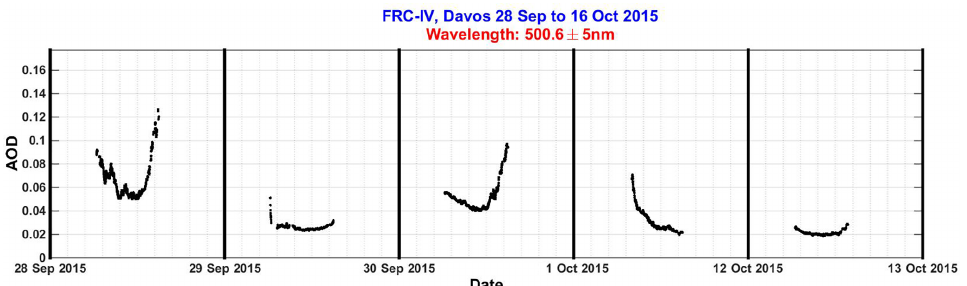
Figure 1. Average AOD at 500nm measured by the three reference PFR instruments (WORCC triad) during 5 days with cloud-free sky conditions. Data points represent 1min